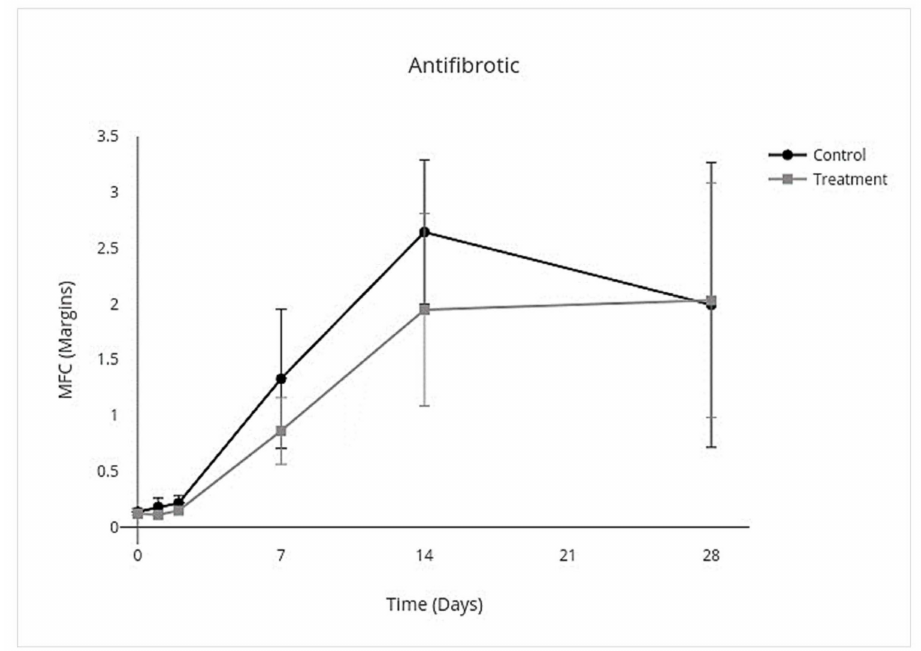
Figure 11. MFC of mRNA expression of antifibrotic cytokines over time following IV allo-CB-MSC therapy. In the treatment group, there was neither overall treatment effect over all days nor significant treatment effect on individual days. Table 5. GEE analysis of mRNA cytokine expression of limb wounds following IV allo-CB-MSC administration.